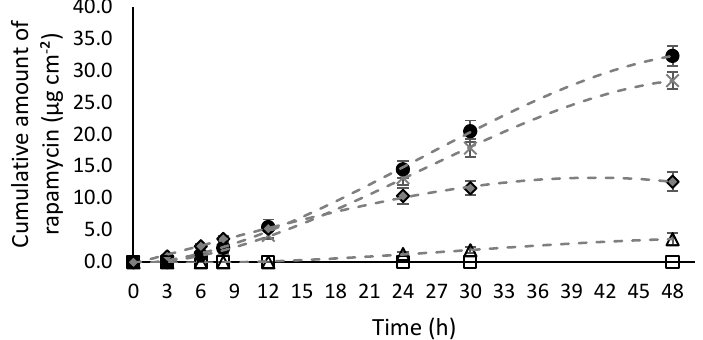
Figure 1. Cumulative amount of rapamycin (µg cm −2 ) diffused through Strat-M ® membrane during 48 h. □ corresponds to F1 (0.1% rapamycin API (active pharmaceutical ingredient) dispersed in petroleum ointment); ∆ corresponds to F2 (0.1% rapamycin API dispersed in Dexeryl ® cream); × corresponds to F3 (0.1% rapamycin solubilized in Transcutol ® P and mixed in Excipial ® hydrocream); ♦ corresponds to F4 (0.1% rapamycin oral solution Rapamune ® ) and ● corresponds to F5 (0.1% rapamycin hydro-alcoholic gel). Each point corresponds to the mean of 6 assays ± SD. Table 4. Permeation parameters for the 0.1% rapamycin formulations.